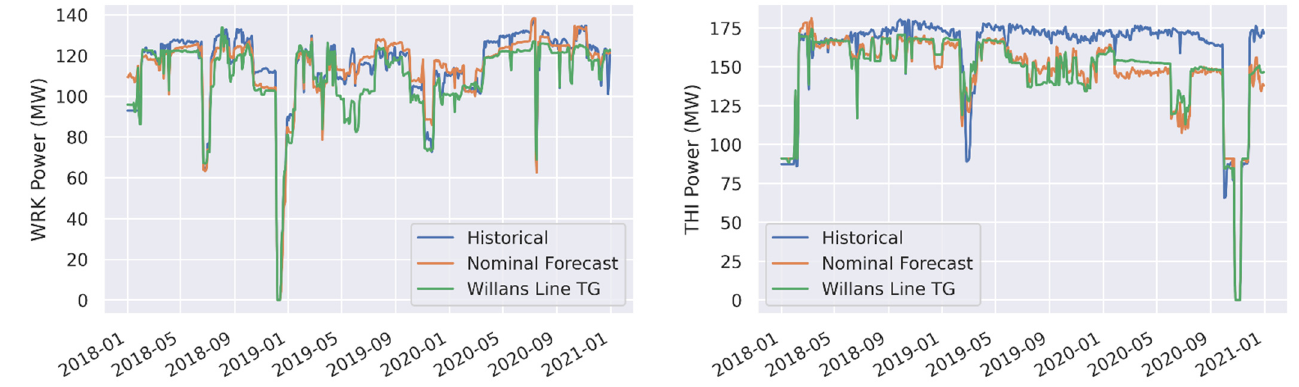
Figure 7. Wairakei ( left ) and Te Mihi ( right ) system power generation, comparing historically measured data versus the nominal forecast model (including the turbine generator multi-linear regression model) and the Willans Line turbine generator forecast (using a constant value for turbine generator steam consumption rate).